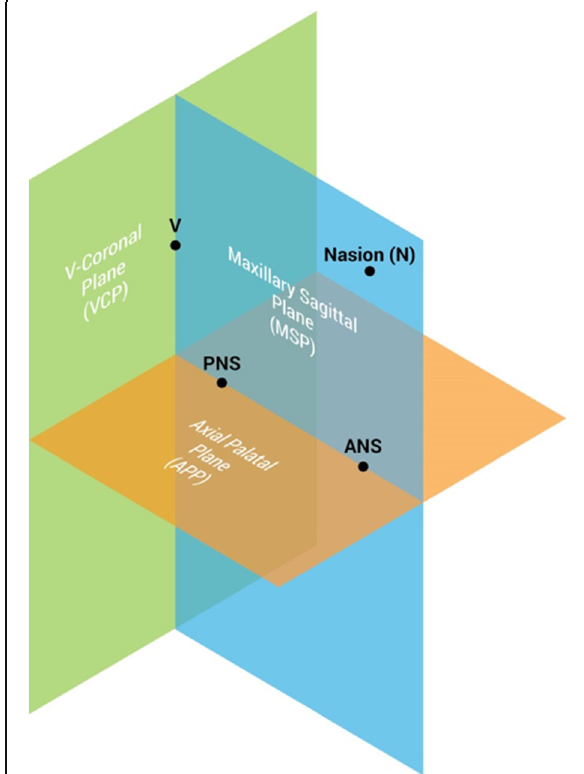
Fig. 3 Schematic representation of the three main reference planes: maxillary sagittal plane (MSP), axial palatal plane (APP), and V-coronal plane (VCP). Reference planes are localized in the pre-expansion CBCT and become the reference lines to measure the displacement of skeletal structures in the post-expansion